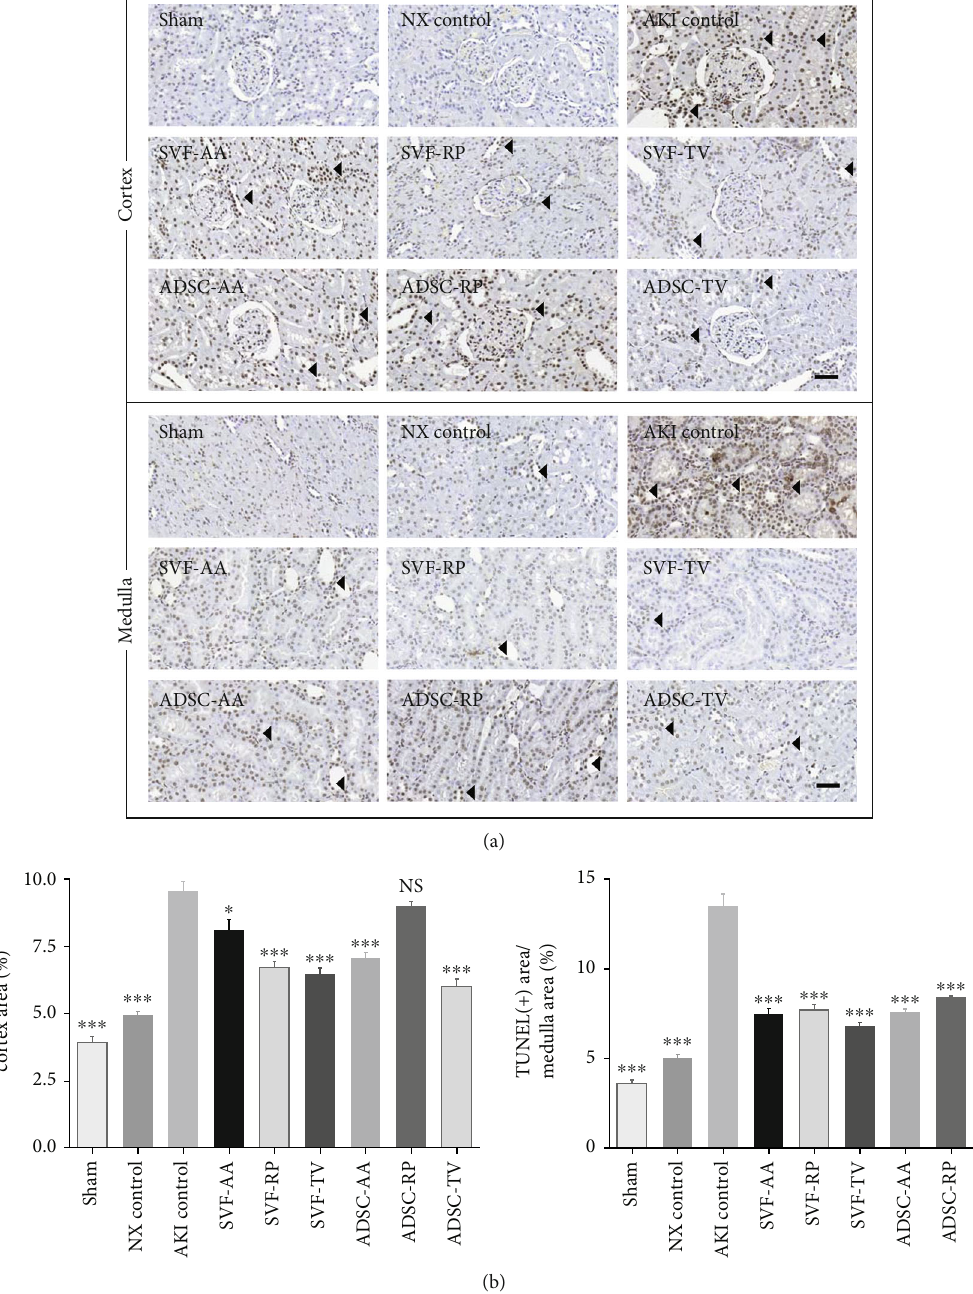
Figure 7: Apoptosis marker of kidney tissue. (a) Representative photomicrographs of cortex and medulla. Arrowheads indicate nuclei stained positive for TUNEL. (b) Ratio of area stained positive for TUNEL to random cortex area (left) medulla area (right). Representative photomicrographs of (right). Magni fi cation × 40. Scale bar 50 μ m. NS, p > 0 : 05 ; ∗ p < 0 : 05 ; ∗∗∗ p < 0 : 001 compared to the AKI control group. 4 fi elds per rat; 10 rats per group, but 8 rats in the SVF-AA and ADSC-AA